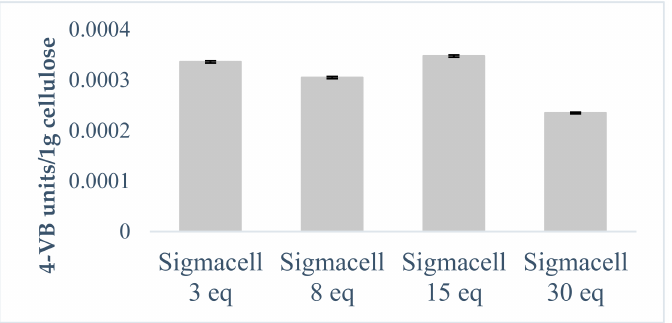
Figure 4. Number of 4-VBC groups attached to 1 g of Sigmacell depending on equivalents of 4-VBC used. Calculated by measuring the UV absorption of DMSO suspensions at 265 nm.